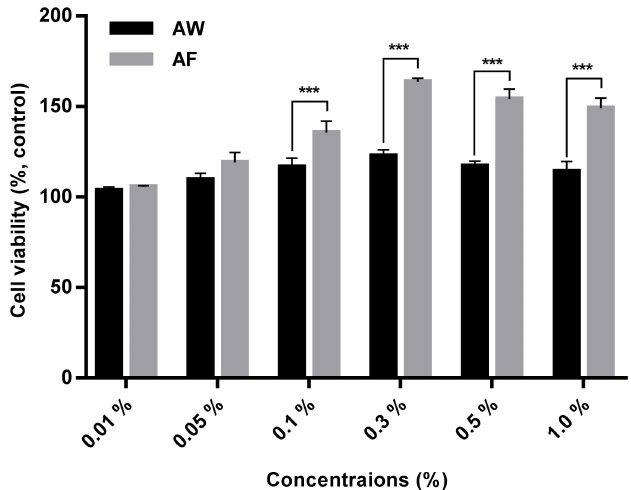
Figure 2. Cytotoxicity of the Aloe vera leaf skin extracts prepared using two different processes against human skin fibroblast cells. AW: Hot water extraction of Aloe vera leaf skin at 100 ◦ C for 24 h. AF: L. plantarum fermentation of Aloe vera leaf skin at 37 ◦ C for 3 days and extraction using an ultrasonicator at 40 kHz for 1 h at room temperature. The mean values ± SD for separate triplicate experiments are shown, and error bars represent the SD. The significance of the difference was set to *** p < 0.001 compared with each group.